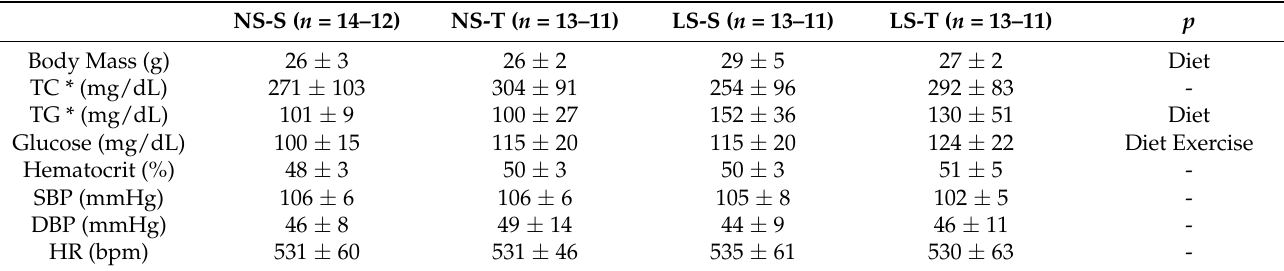
Table 2. Characterization of groups after